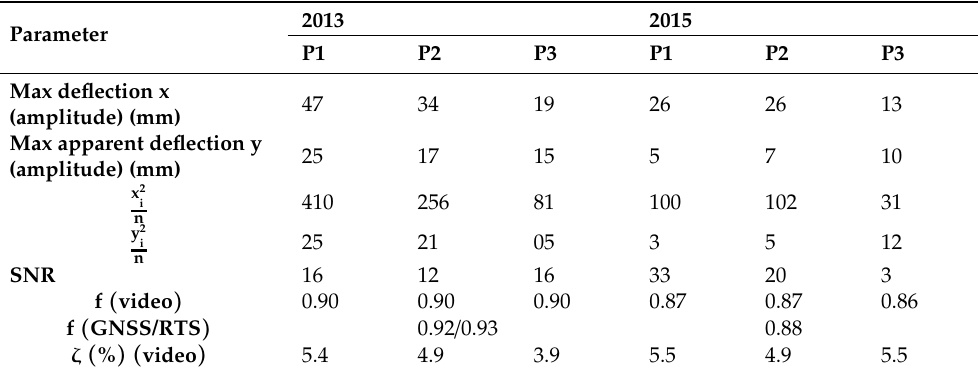
Table 2. Summary of the results.